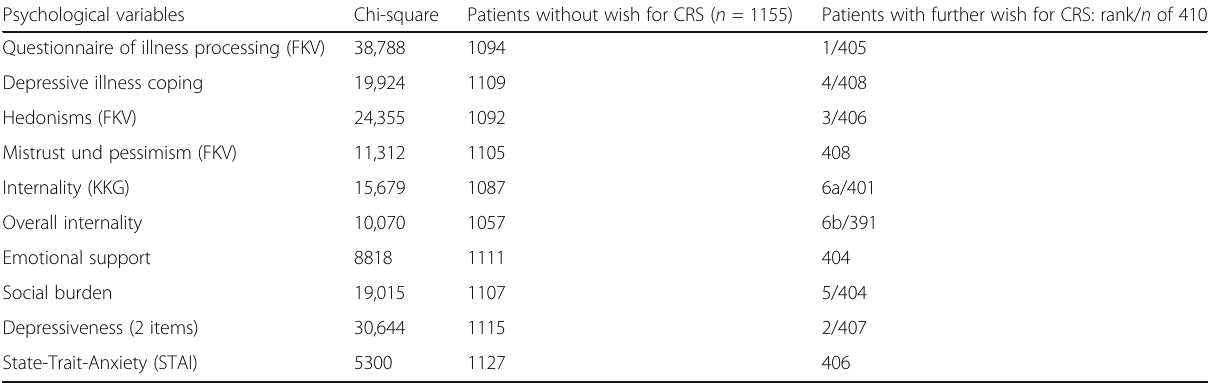
Table 9 Differences between patients without ( N = 1155) and those with ( N = 410) wish for further CRS Psychological